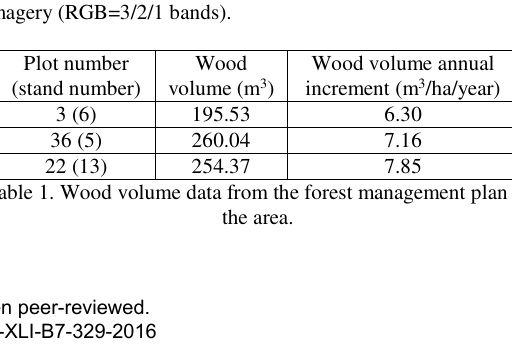
(c) Figure 1. The location of the study area, (a) in the geographical area of Greece, (b) a zoom of the study area in the map shown in 1(a), (c) the boundaries of the University Forest of Taxiarchis on Google Earth © Google Earth, copyright 2016. Figure 2. The location of the plot surfaces on the satellite